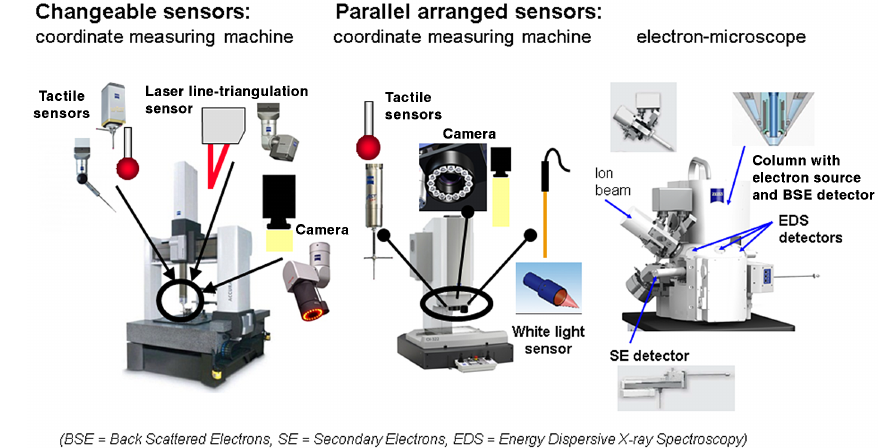
Figure 7. Examples of multi-sensor implementations in coordinate measuring machines and electron microscopes (BSE – back-scattered electrons, SE – secondary electrons, EDS – energy-dispersive X-ray